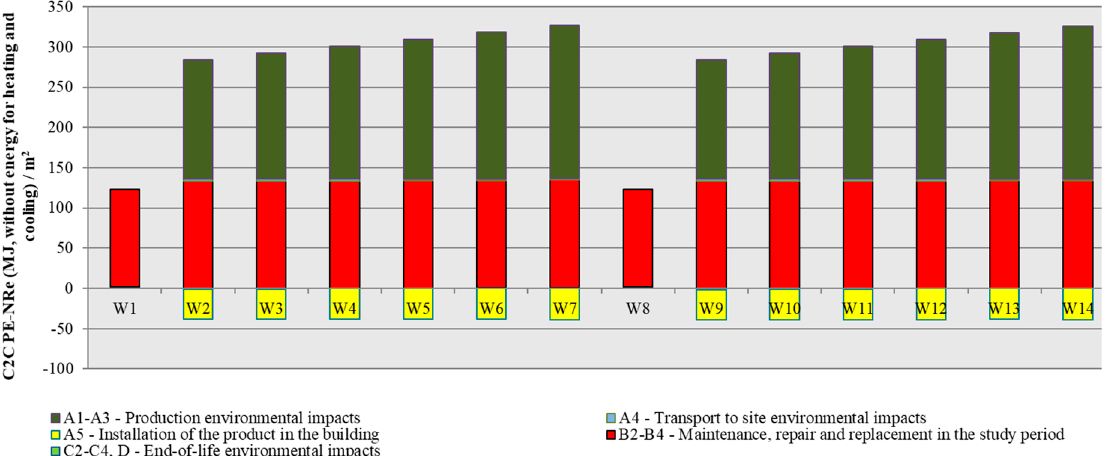
Figure 4. C2C consumption of nonrenewable primary energy (PE-NRe, in MJ, without energy for heating and cooling) / m 2 of the external wall alternatives with ICB.